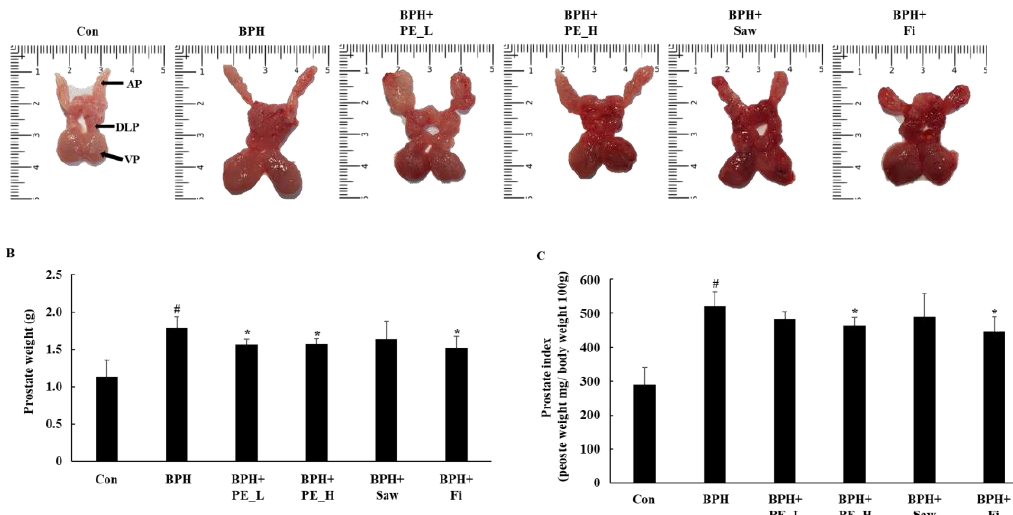
Figure 2. Effect of PE administration on prostate tissue weight in testosterone propionate (TP)-induced benign prostatic hyperplasia (BPH) rats. ( A ) The representatives of prostates tissue in each group; the tissue was from the dorsolateral prostate (DLP), ventral prostate (VP), and anterior prostate (AP). ( B ) The total prostate weight of the rats. ( C ) Prostate indexes. Note: Con, normal control group; BPH, TP (3 mg/kg/d)/corn oil injection; BPH + PE_L, 100 mg/kg of PE treated BPH group; BPH + PE_H, 200 mg/kg of PE treated BPH group; BPH + Saw, saw palmetto extract treated BPH group; BPH + Fi, Fi treated BPH group. Data are presented as mean ± SEM ( n = 6). Significant differences at ##P <